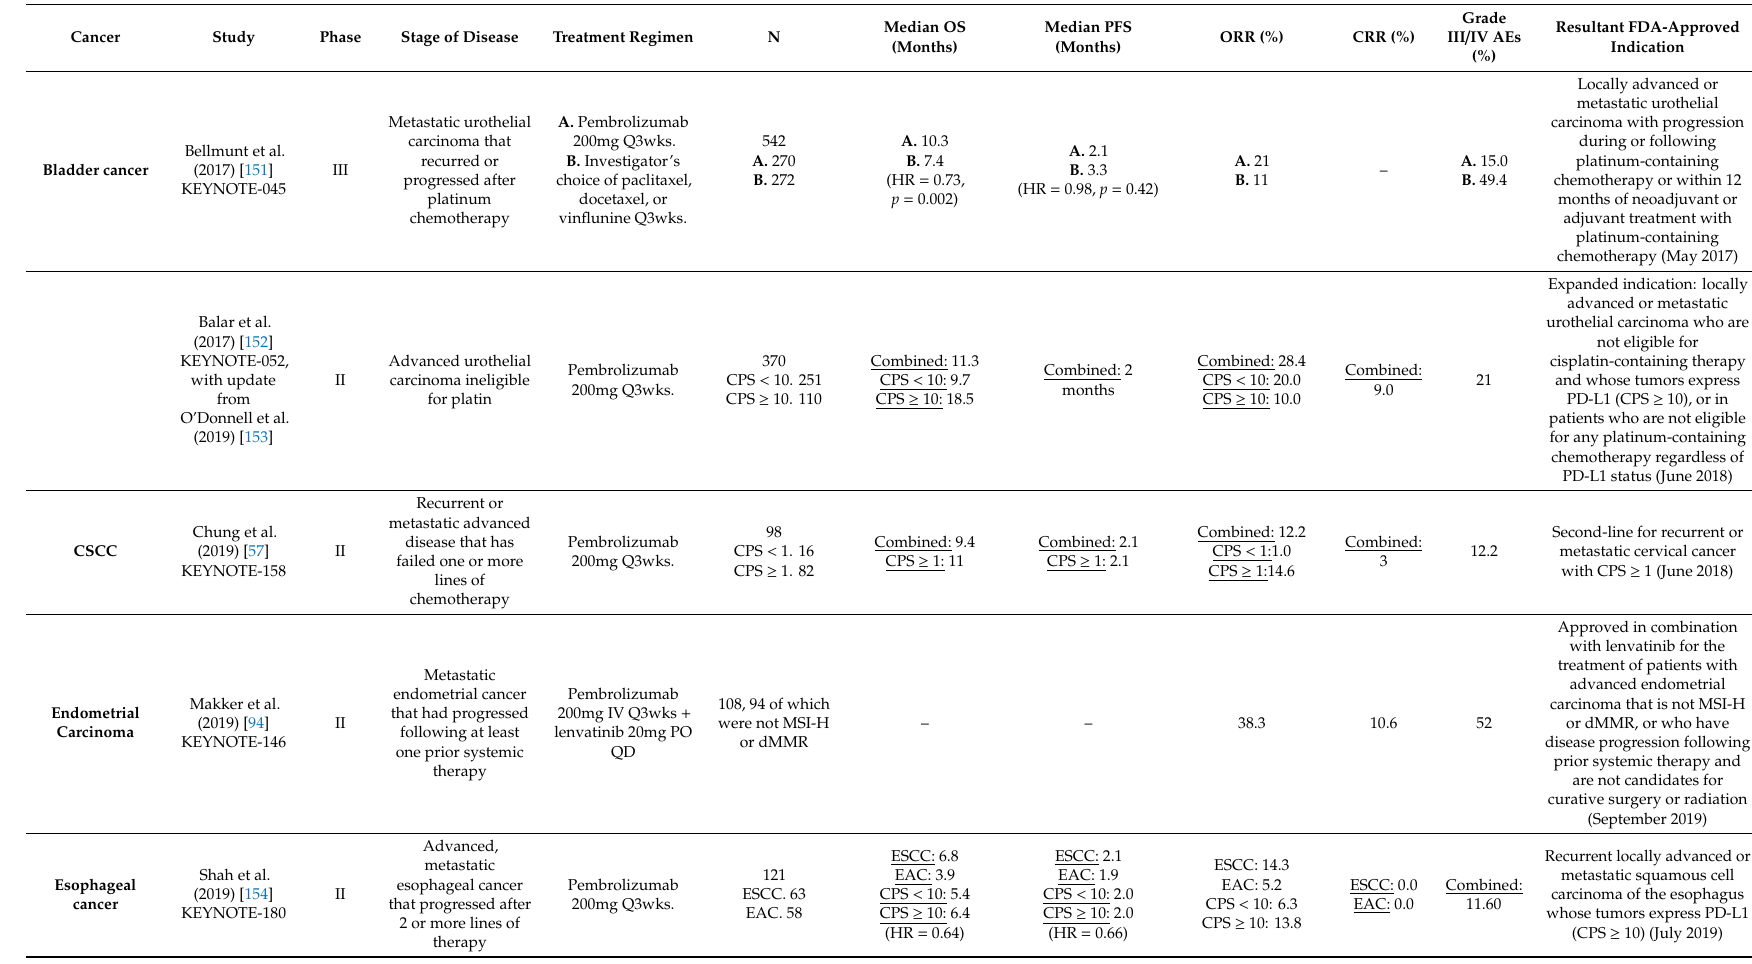
Table A4. Select clinical data for